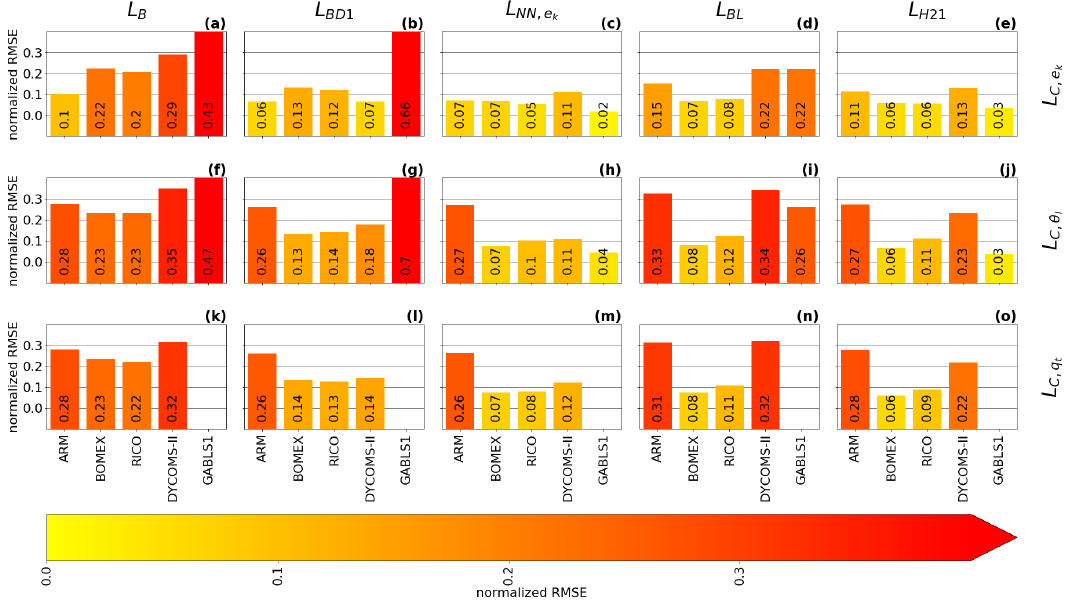
Figure 12. Same content as Figure 11, but for the second smallest sub-domain size ( N sd = 16 2